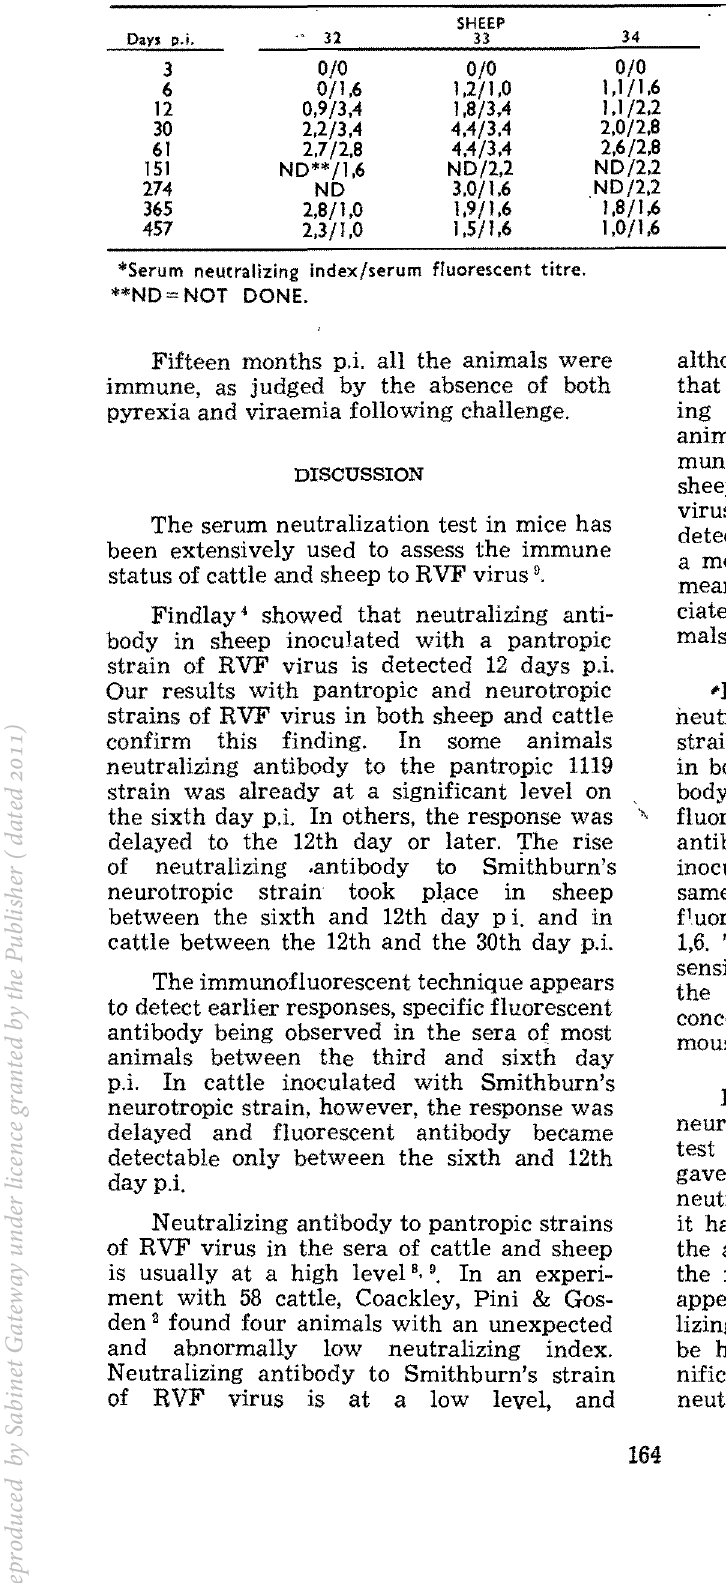
Table 5: ANTIBODY RESPONSE OF SERA OF SHEEP AND CATTLE INOCULATED WITH SMITHBURN'S NEUROTROPIC STRAIN OF RVF VII\.US SHEEP Days